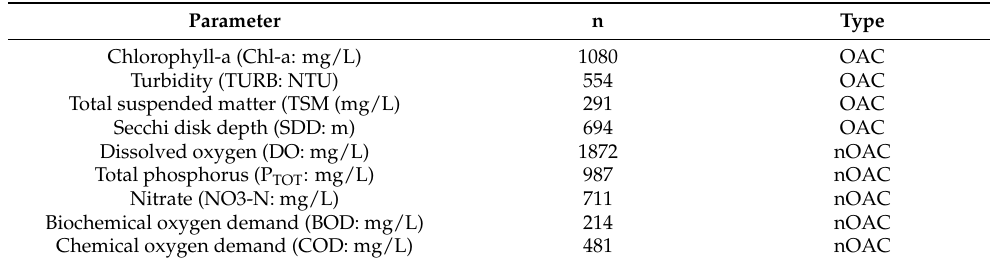
Table 4. Number of cleaned samples per parameter. Type column refers to optically active constituents (OAC) and non-optically active constituents